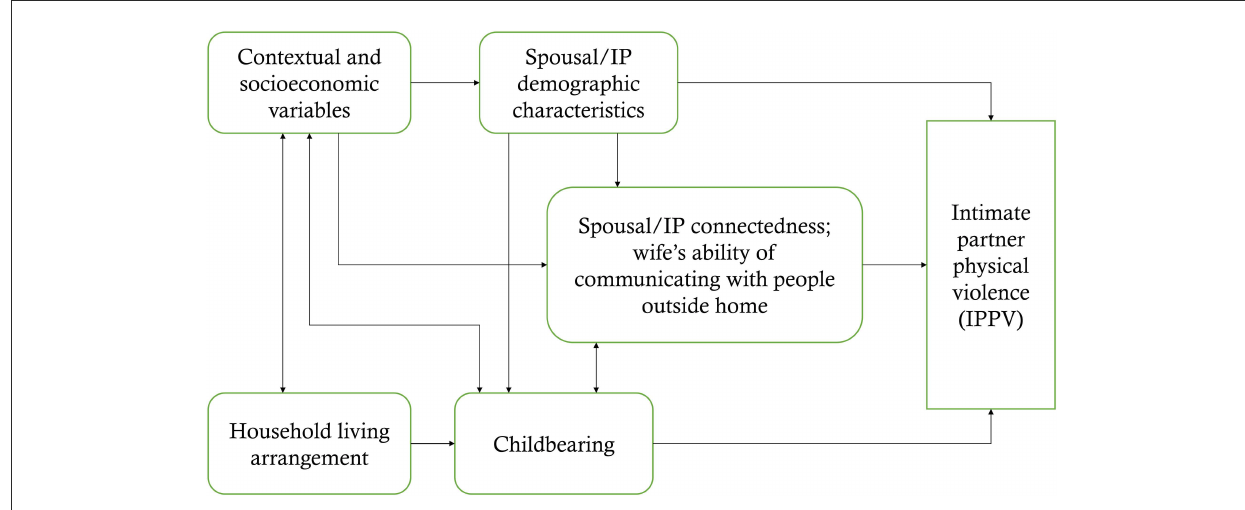
FIGURE1 Association of spousal/intimate partners’ (IP) demographic characteristics, household living arrangement, childbearing, and partner control with IPV.